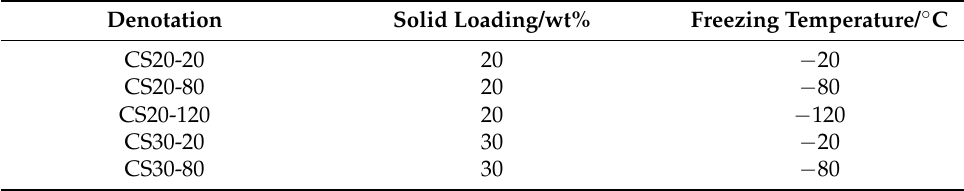
Figure 1. Flowchart of the manufacturing route via freeze − casting used in this study. Cutting of the screens after pyrolysis was performed in multiple steps, first removing a 1 mm layer from each end and discarding it. When the sample thickness was around 2.6 mm, the screens were polished with sandpaper (SiC) with a grit size of 500 and sonicated for at least 30 min until the thickness of the screens was around 1.5 mm ( L n , z -direction). The height ( x -direction) and width ( y -direction) of the screens was 55.7 mm and 17.5 mm, respectively. Testing of the screen with 30 wt% and frozen at − 120 °C was not possible due to constant cracking after pyrolysis. Table 1 lists the samples in this study. Table 1. Denotation, solid loading, and freezing conditions.